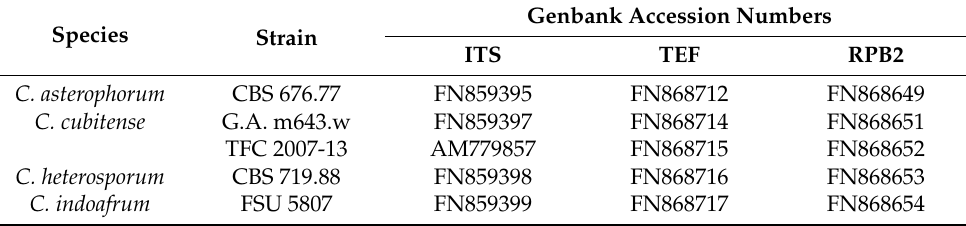
Table 1. Sequences and GenBank accession numbers of Cladobotryum and Hypomyces isolates used in the phylogenetic